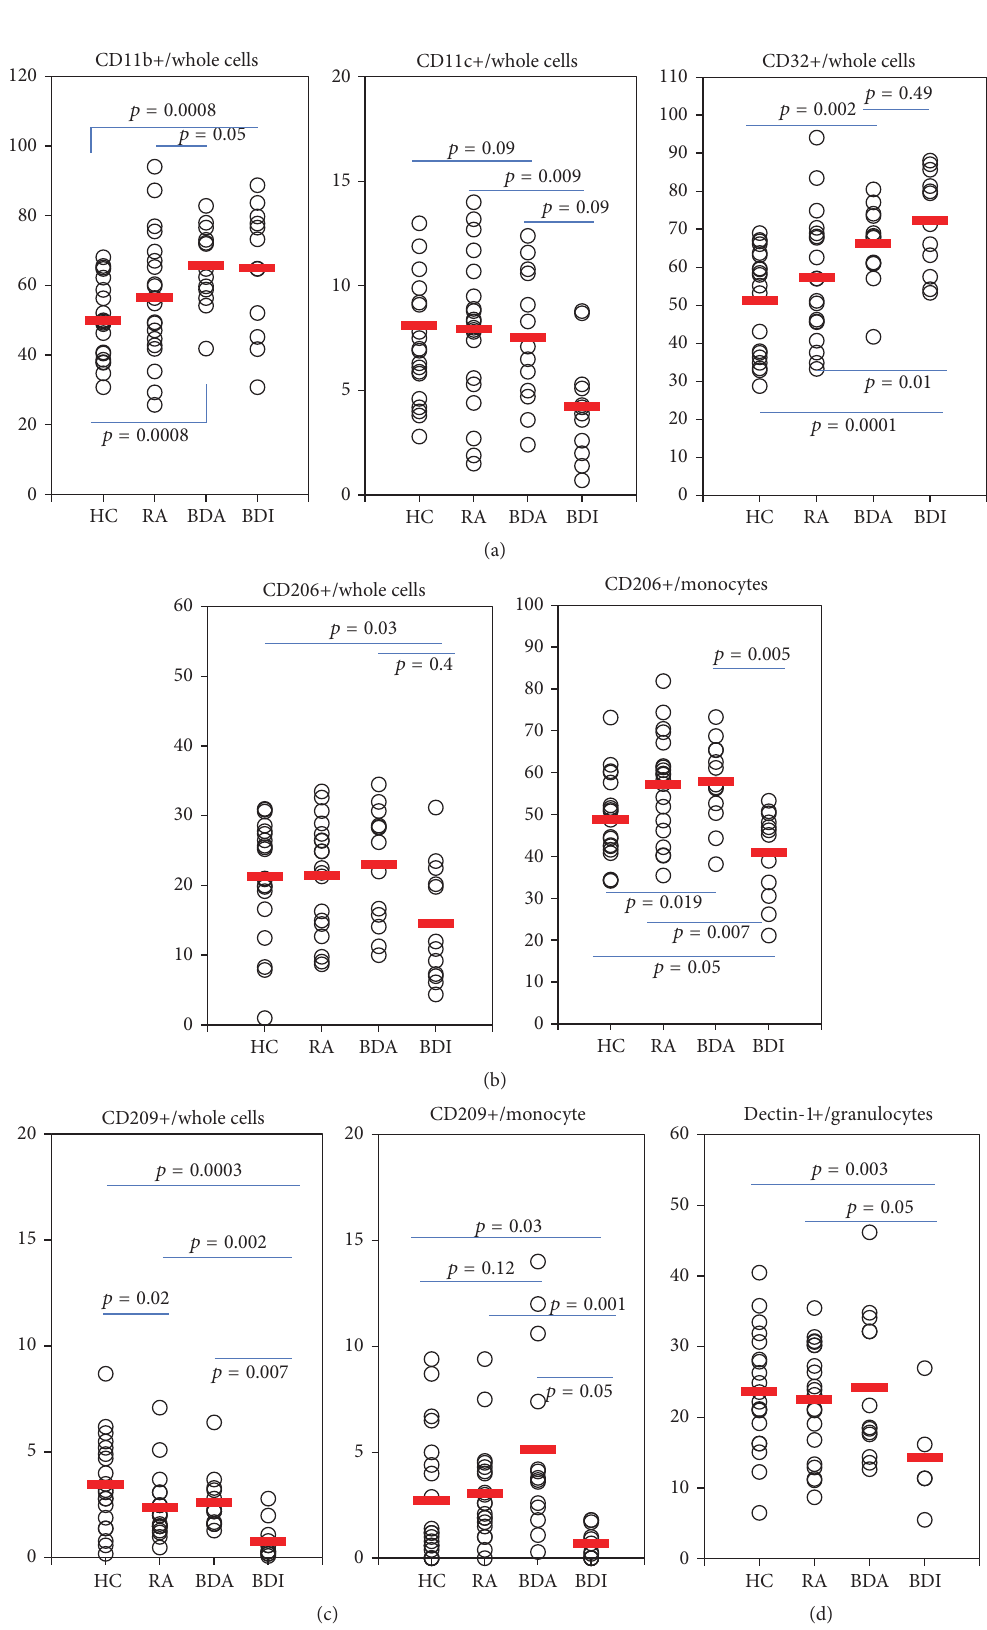
Figure 1: The frequencies of CD11b, CD11c, CD32, CD206, CD209, and dectin-1 positive cells in patients with active Behc¸et’s disease (BDA), inactive BD (BDI), rheumatoid arthritis (RA), and healthy control (HC). The frequencies of CD11b, CD11c, and CD32 positive cells were analyzed in whole leukocytes. The frequencies of CD206, CD209, and dectin-1 positive cells were analyzed in whole leukocytes, granulocytes, and monocytes